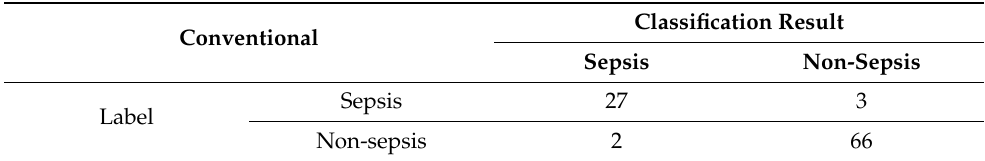
Table 1. Confusion matrix which we set the relation vector as the average vector. Classification accuracy achieved 94.9% (93/98).